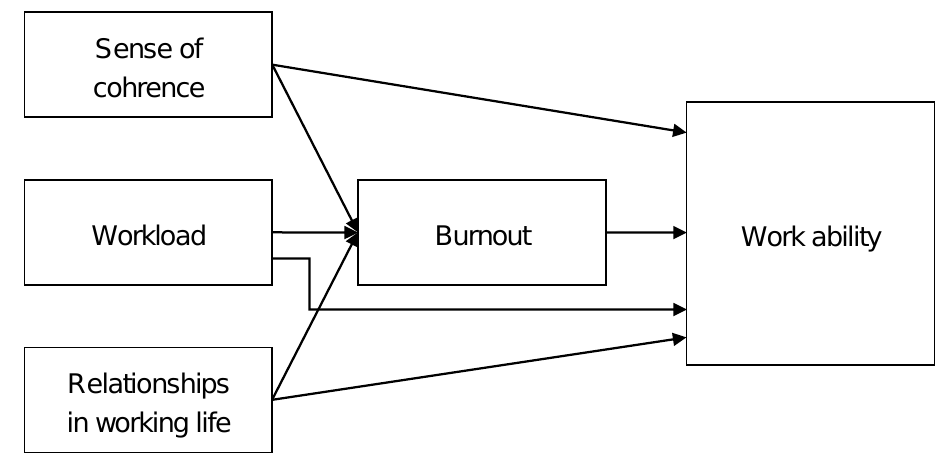
Figure 1. Proposed mediation model. Table 4. Structural coe ffi cients and tests of indirect and overall e ff ects on work